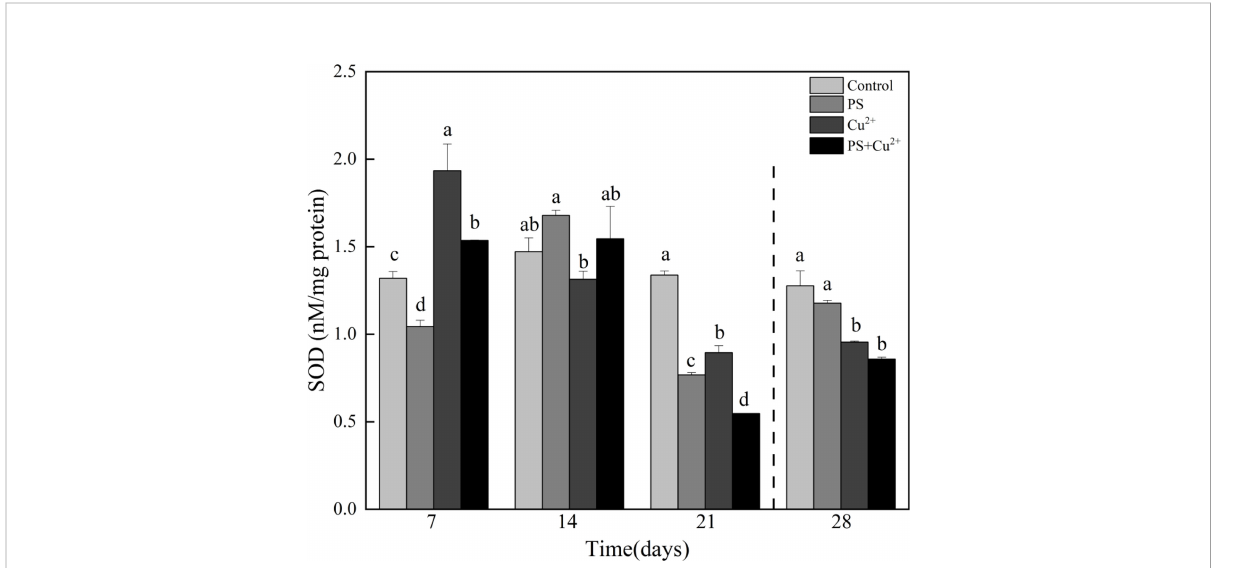
FIGURE 1 Superoxide dismutase (SOD) activities in whole tissues of Tachypleus tridentatus exposed to 100-nm micro-PS (10 4 particles l -1 ), Cu 2+ (10 µg l -1 ), and a combination of PS and Cu 2+ at days 7, 14, and 21, allowed to recover for 7 days (28 days). Data are provided as mean values ± standard deviations. The superscripts of different lowercase letters indicate signi fi cant differences (p < 0.05) between the four